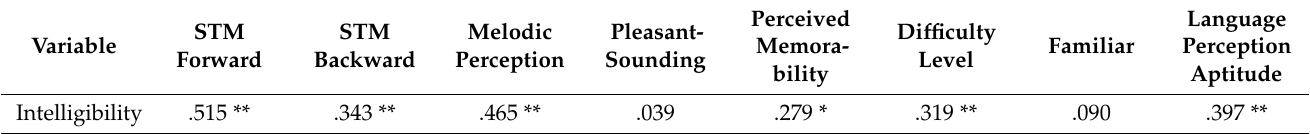
Table 3. The correlations between short-term memory and language measures.